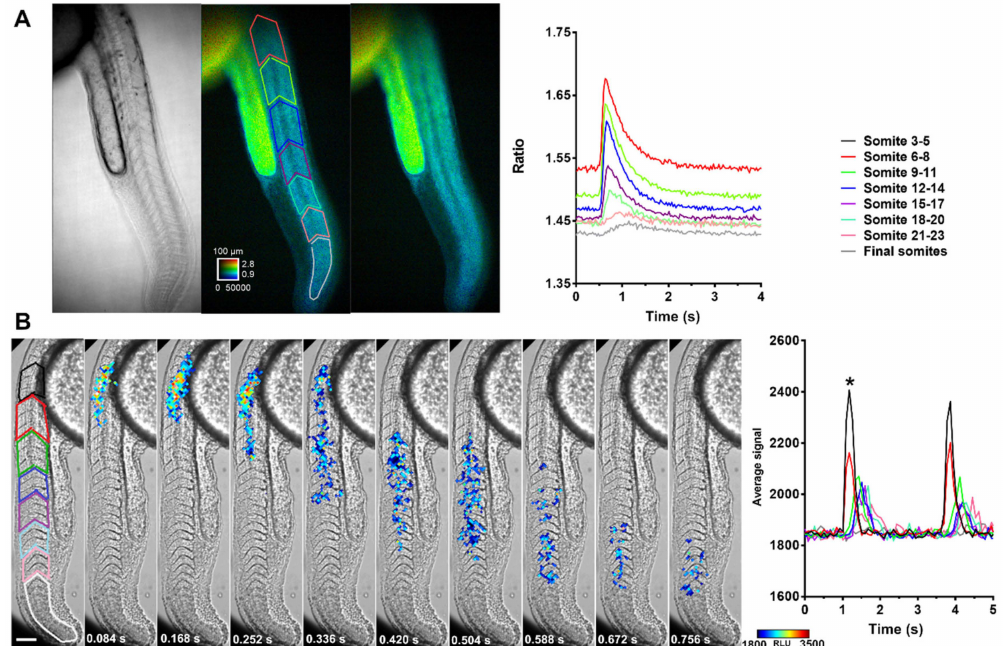
Figure 8. Propagation of Ca 2 + transients along the trunk and tail in embryos expressing Twitch-4 and GA. ( A ) Transmitted light and emission ratio at rest and during a Ca 2 + transient in a Twitch-4 expressing embryo at 28 hpf. The calibration square shows 100 µ m, hue codes for emission ratio, and intensity codes for fluorescence. Fluorescence images were acquired at 33 Hz. ROIs were drawn over somites in groups of 3 (colored traces). The graph shows the time course of a Ca 2 + transient in the indicated color-coded ROIs. ( B ) Snapshots of a Ca 2 + transient in a GA-expressing embryo with luminescence overlaid on transmitted light images. ROIs were selected on the indicated somites in the left panel in groups of three (colored traces). Images were acquired at 11.9 Hz. The scale bar represents 100 µ m. The color scale indicates RLU. The graph shows the time course of luminescence during two contractions on the indicated somites. The snapshots on the left correspond to the first contraction